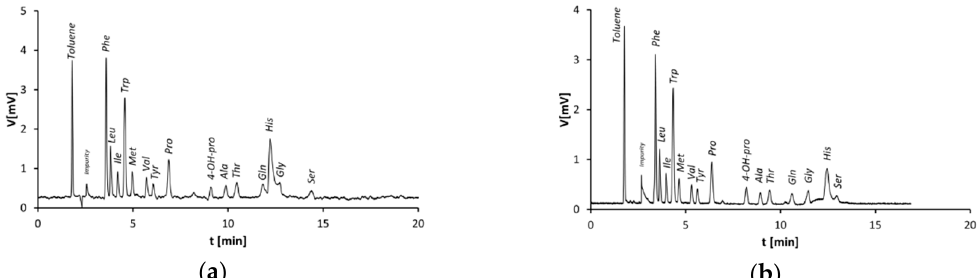
Figure 3. HILIC separation of fifteen amino acids on MSA monolithic capillary column. Operating